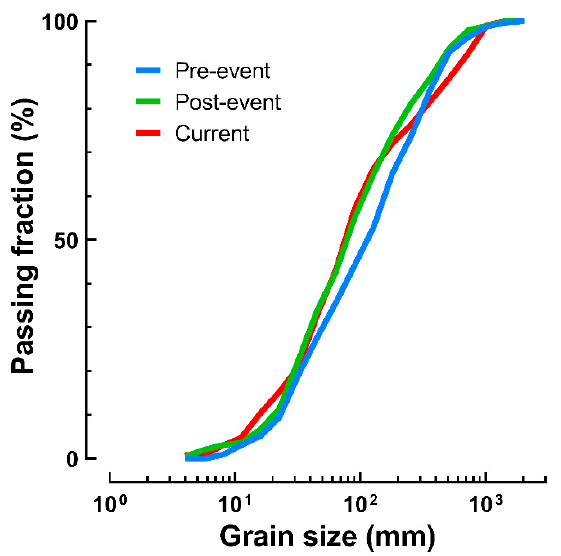
Figure 8. Grain size distributions of Rio Cordon surficial material measured pre-event, post-event, and in the current conditions.